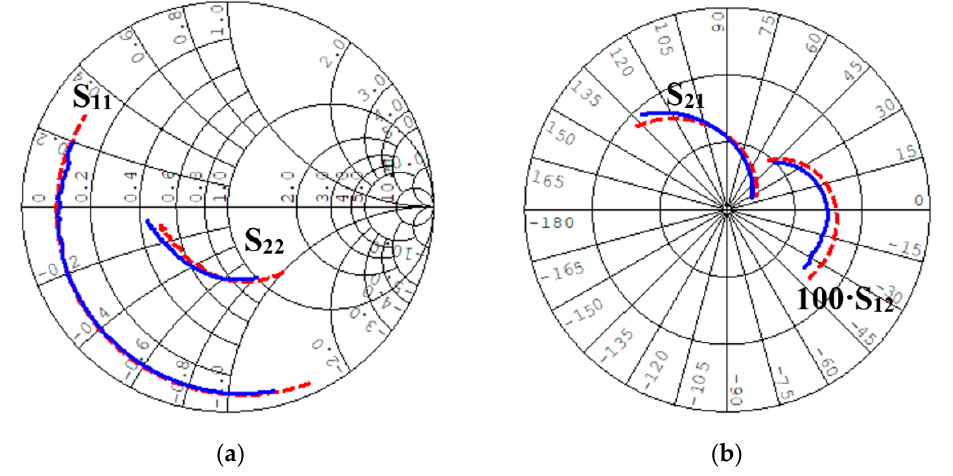
Figure 13. Scattering parameters measured by NRL with transmission lines (red dashed line) and UniME (blue solid line) for a HEMT with gate width of 6 × 50 μ m (3.5–26 GHz). ( a ) S 11 and S 22 , ( b ) S 21 and 100 · S 12 . V DS = 2 V and I DS = 60 mA.